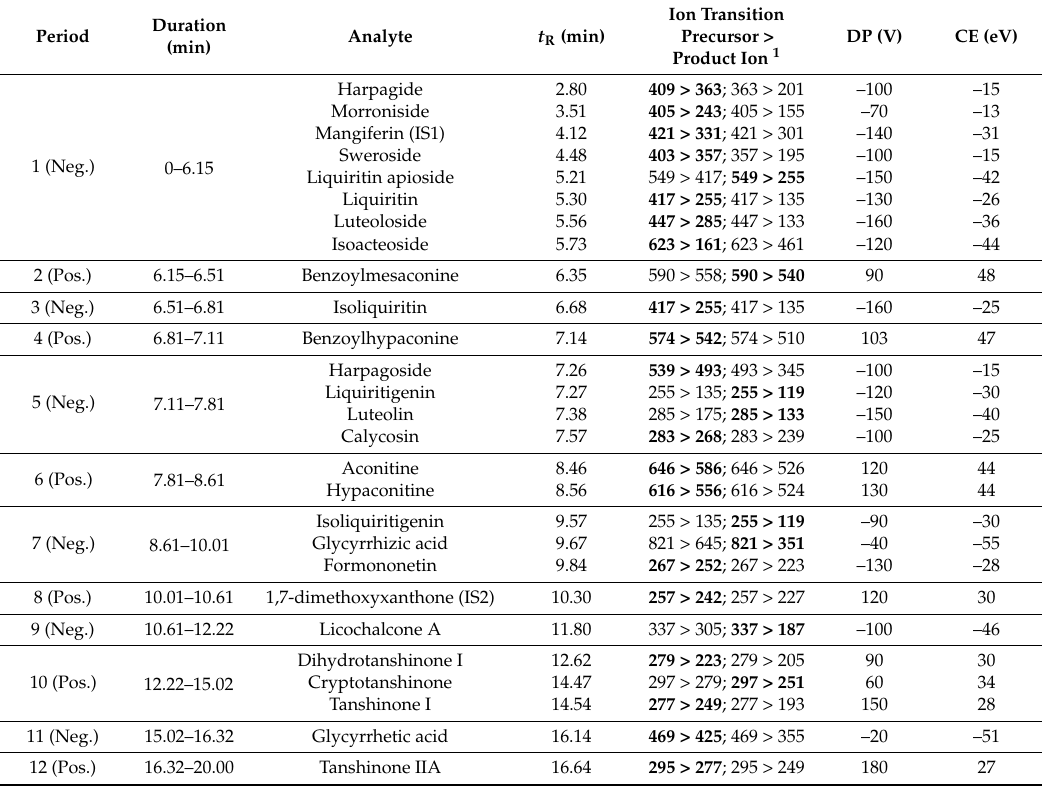
Table 1. The retention times ( t R ), MRM ion transitions, declustering potentials (DPs), collision energies (CEs) of the targeted components and twelve periods of the polarity switching mass